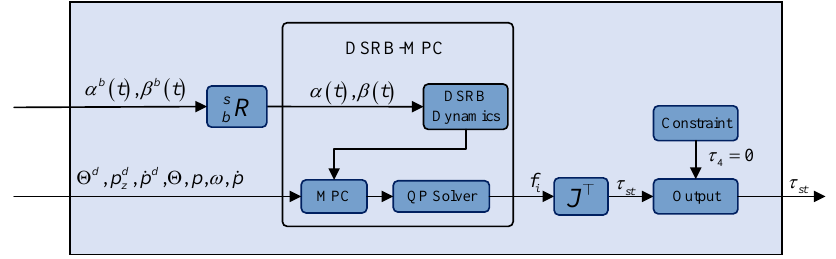
Figure 5. Block diagram of the stance leg controller. α b ( t ) and β b ( t ) represent the disturbances to the centroid acceleration and rotational acceleration expressed in { B } , whereas α ( t ) and β ( t ) express in { S } . Θ d represents the desired Euler angles, whereas Θ represents the actual value. ˙ p d represents the desired centroid velocity, whereas ˙ p represents the actual value. ω represent the actual angular velocity. p d z represents desired centroid height. p represents the actual centroid position. f i is the GRF. τ 4 represents the torque of foot joint. τ st represents the torques of the stance leg. s matrix which transforms from { B } to { S } . J is the foot joint